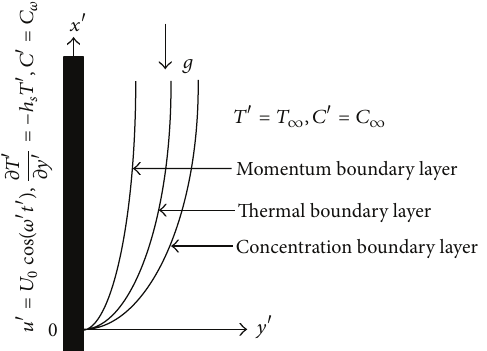
Figure 1: Physical model and coordinate